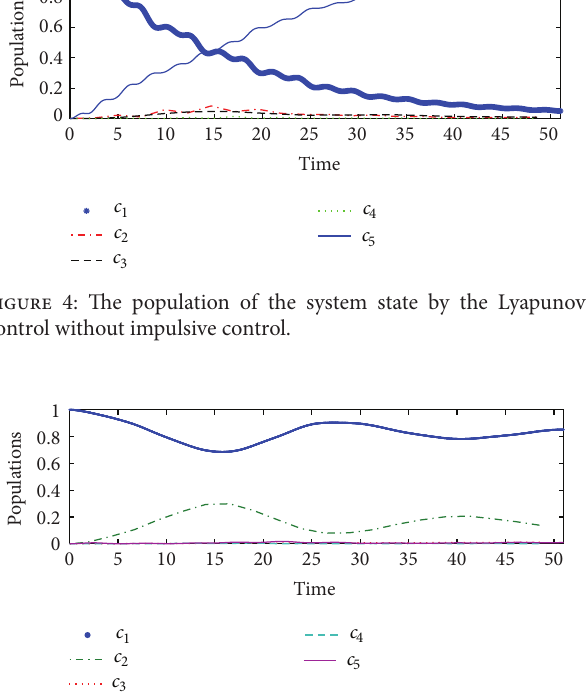
Figure 5: The population of the system state by the implicit Lyapunov control in